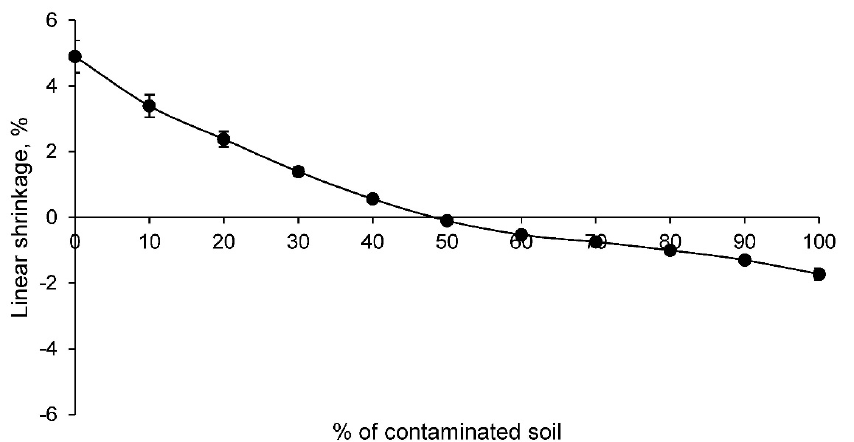
Figure 3. Linear shrinkage of families of ceramics conforming with various percentages of clay and contaminated soil.